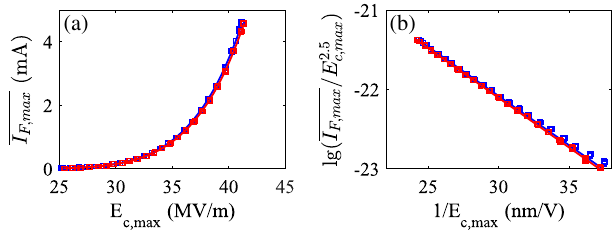
FIG. 16. The dependence of I F; on E c; before (blue) and max max − after (red) the longevity measurement, plotted in the E c; max I F; max coordinate (a) and the F-N coordinate (b). The dots denote the experimental data, and the lines represent the linear fitting results from the F-N